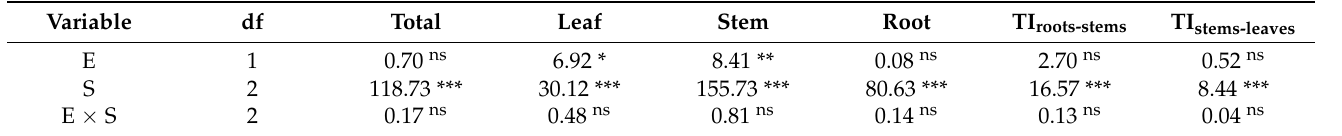
Table 4. Two-way ANOVA for the effects of endophyte (E) and CdCl 2 stress(S) on Cd concentrations in different parts (leaf, stem, root) and the whole, Root to stem transport index (TI roots-stems ) and Stem to leaves transport index (TI stems-leaves ) of Hordeum brevisublatum .